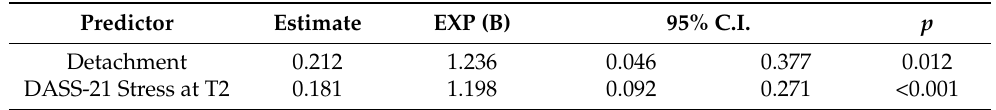
Table 4. The association between significant sociodemographic variables ( n = 173 *) and levels of stress at T3. Predictor Estimate EXP (B) 95% C.I. p Detachment 0.212 1.236 0.046 0.377 0.012 DASS-21 Stress at T2 0.181 1.198 0.092 0.271